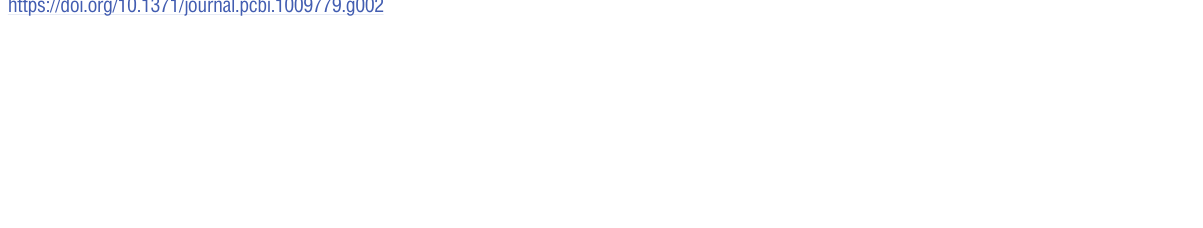
PLOS Computational Biology | https://doi.org/10.1371/journal.pcbi.1009779 January14,